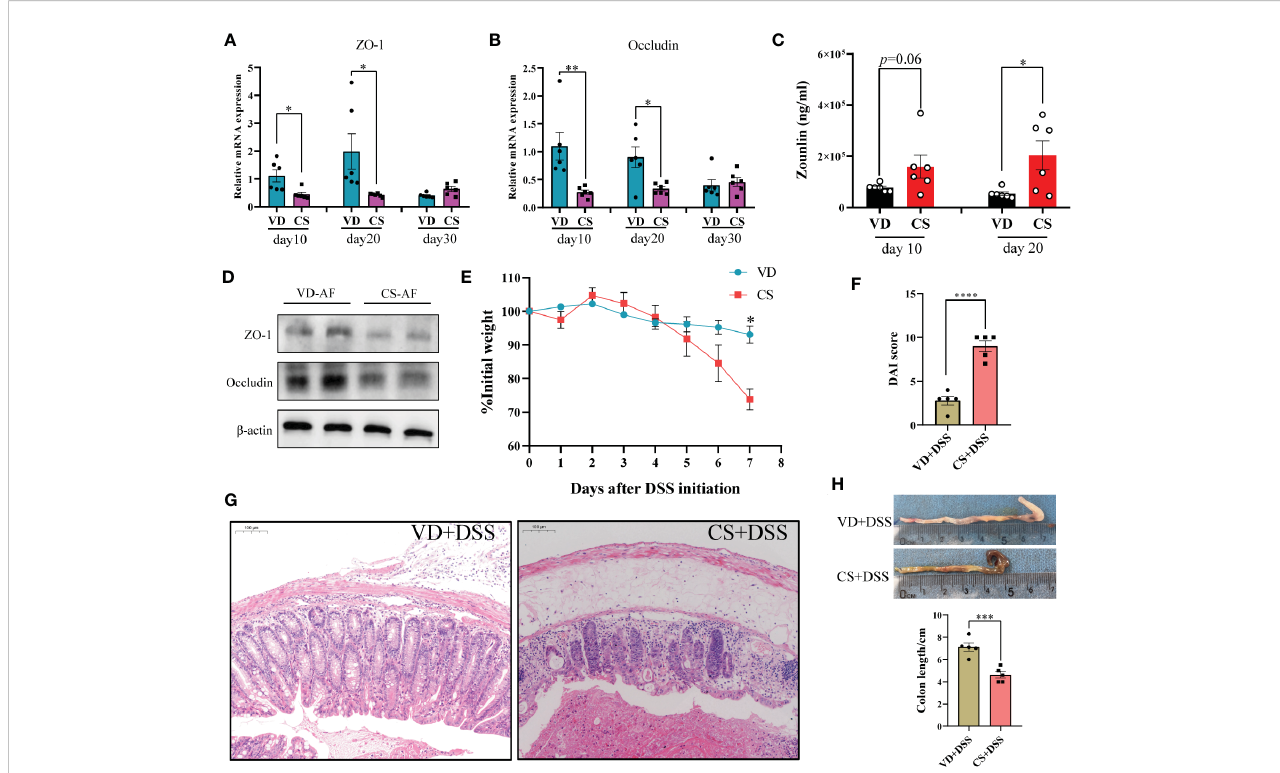
FIGURE 2 Pups delivered by CS exhibited a defective epithelial barrier and an increased susceptibility to DSS-induced colitis. Relative mRNA expression of tight junction protein 1 (ZO-1, (A) and Occludin (B) in colons of CS delivered pups compared with VD pups. (C) , Concentrations of zonulin were quanti fi ed by ELISA in serum of VD (n = 6) and CS (n = 6) pups at day 10 and day 20. (D) , Protein expression of ZO-1 and Occludin in CS amniotic fl uid (AF)-treated NCM460 cells. (E) Weight loss compared to day 0 after administration of DSS in VD (n = 5) or CS (n = 5) pups for 7 days. (F) Disease activity index (DAI) scores for mice in VD and CS groups. (G) Representative H&E-stained colon sections of VD and CS mice after administration of DSS. (H) Representative images of colons of VD and CS mice after administration of DSS. Error bars represent SEM. *p < 0.05, **p < 0.01, ***p < 0.001, ****p <